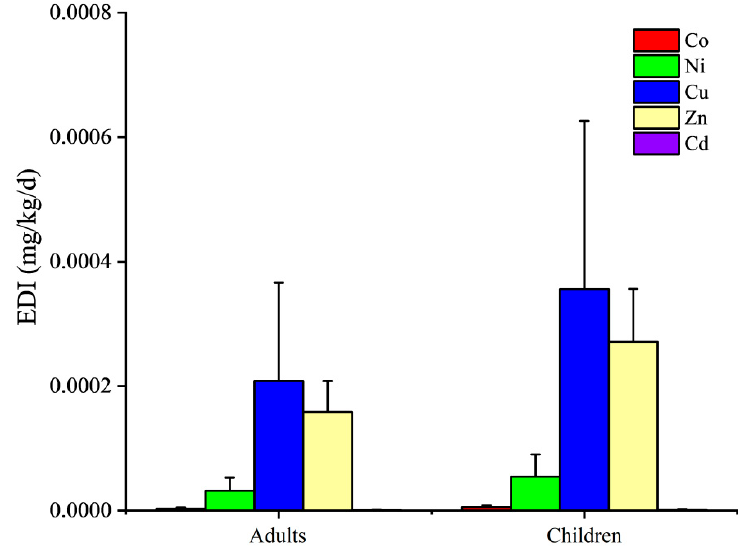
Figure 4. Estimated daily intake of heavy metals for adults and children.